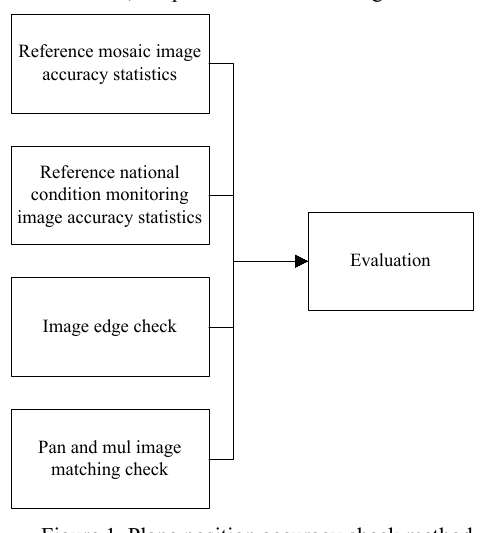
Figure 1. Plane position accuracy check